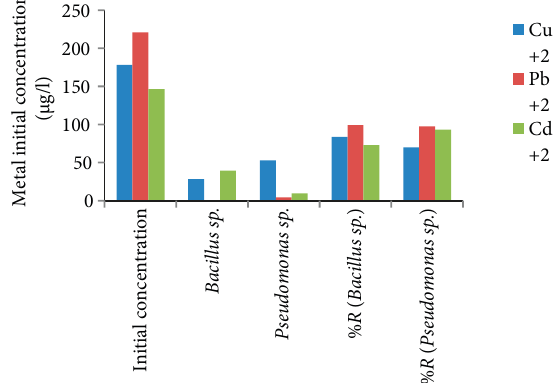
Fig. 4. Comparison between the efficiency of Bacillus sp. and Pseudomonas sp. bio-flocculants for removal of Pb 2+ , Cu 2+ and Cd 2+ at the same initial